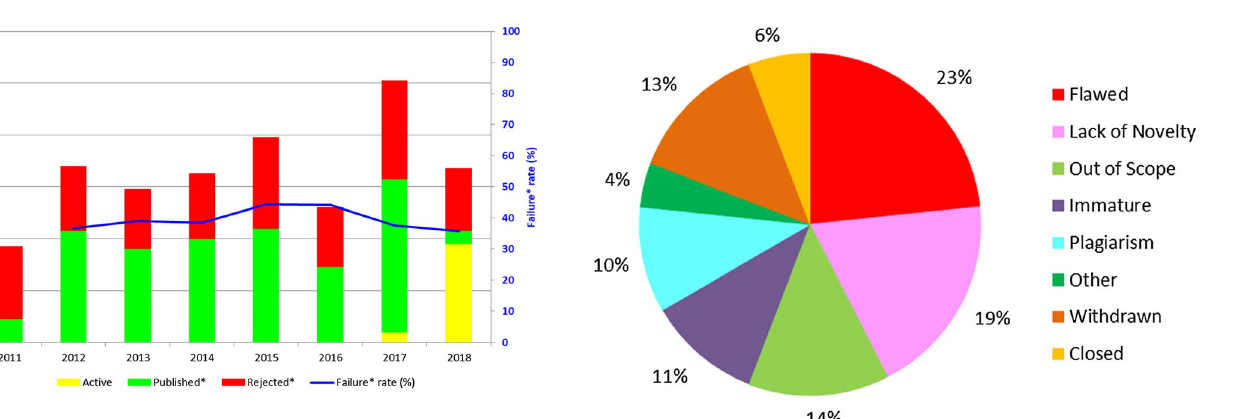
Fig. 3. Evolution of the failure rate per year. Rejected* includes withdrawn and closed manuscripts. Published* includes the editorials and errata. Failure* rate for a year = (Rejected + With- drawn + Closed)/ALL